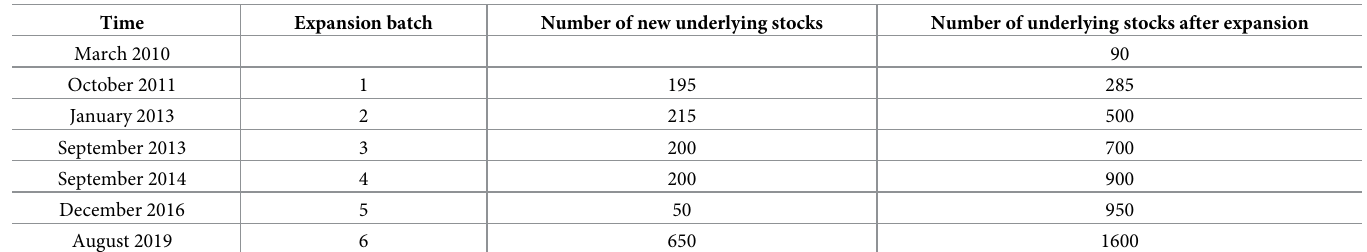
Table 1. Expansions of underlying stocks of margin trading in China’s A-share